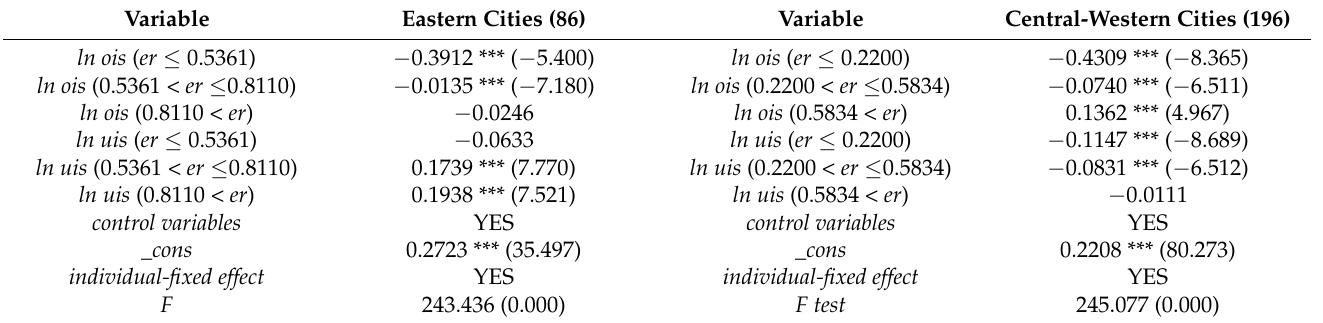
Table 7. Estimation results of the panel threshold effect.